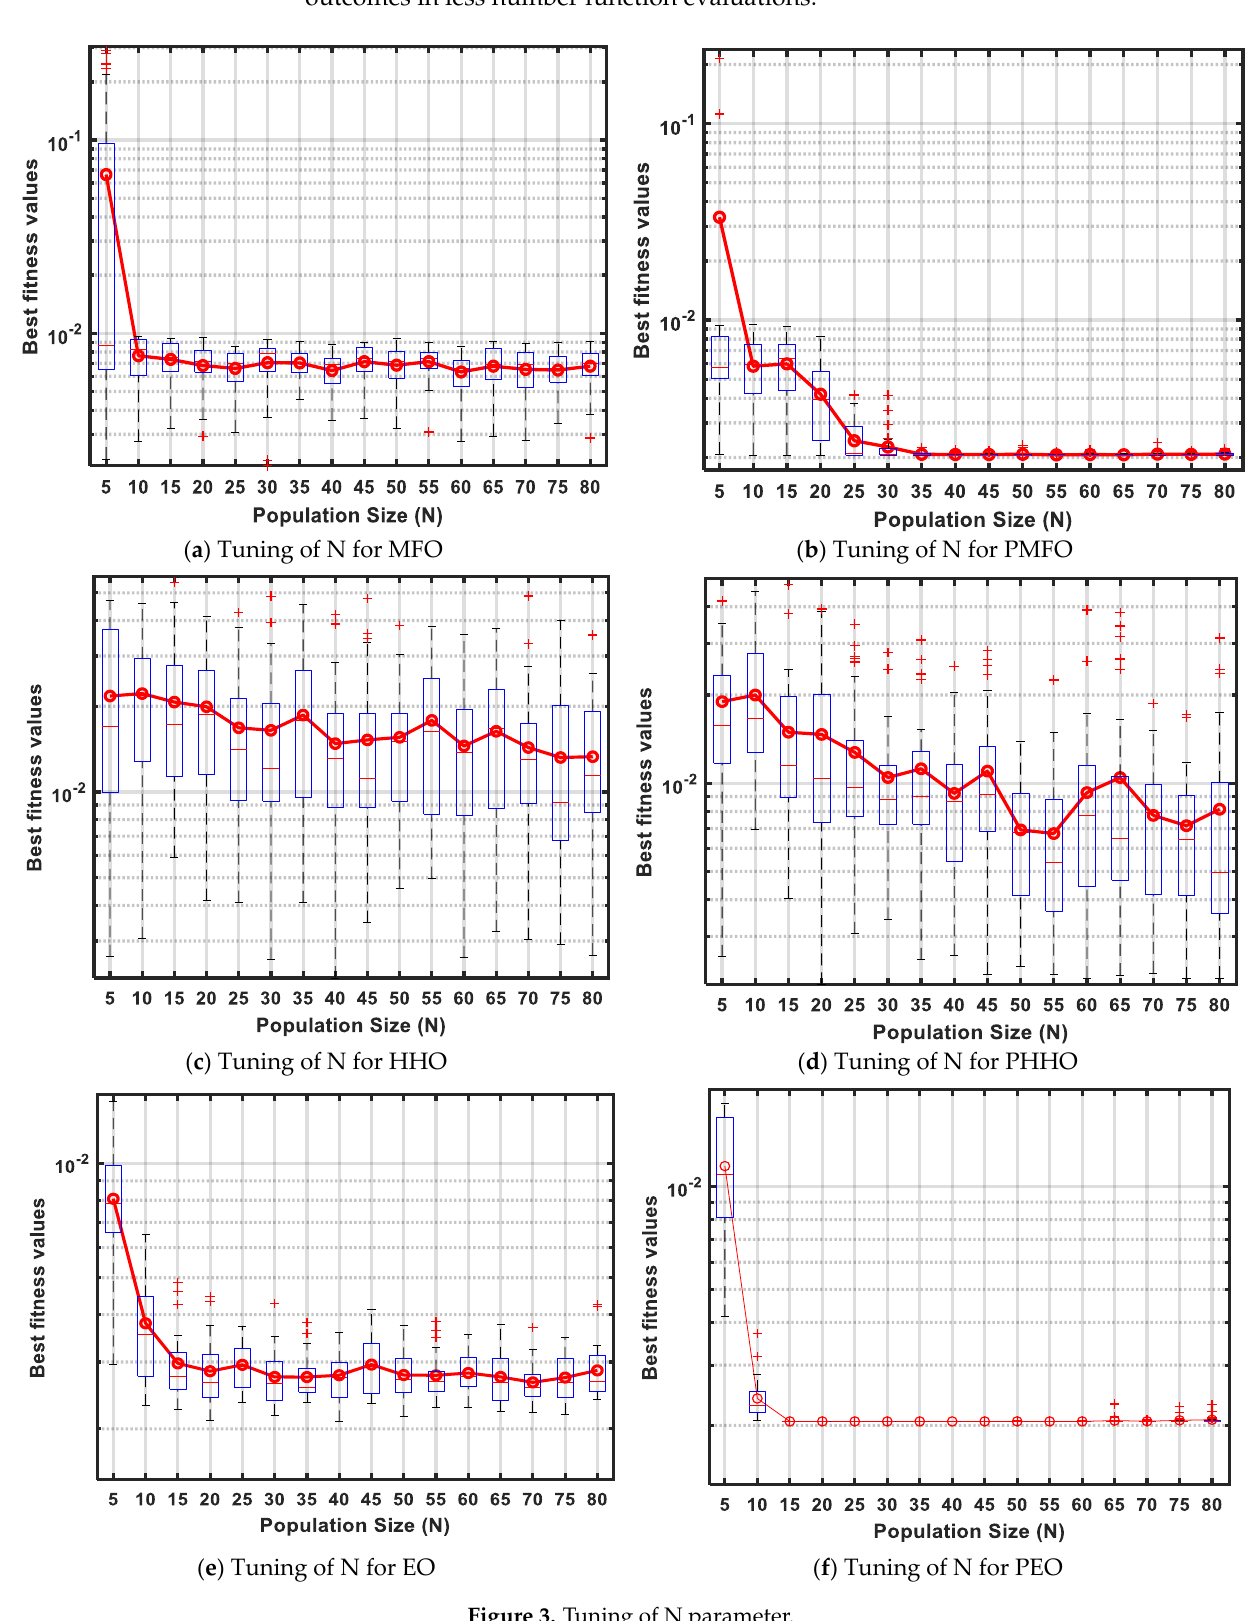
Figure 3. Tuning of N parameter.